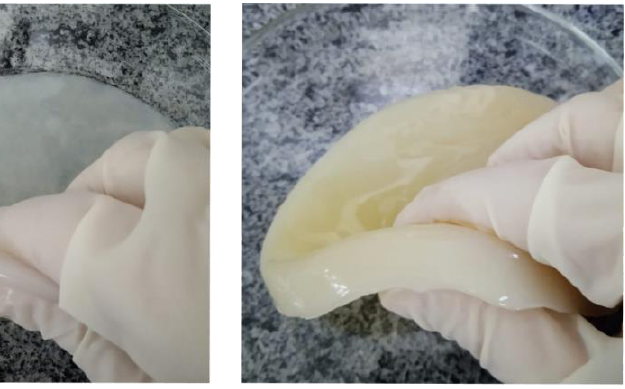
Figure 2. BC production process. Not all bacteria can produce BC. In general, the genera Sarcina , Komagateibacter , Pseu- domonas , Rhizobium and Agrobacterium are good producers. There are also specific culture media for production that must contain sources of carbon, nitrogen, and some mineral salts. The most widely used medium is the one formulated by Hestrin and Schramm [38], which is expensive, as it contains high purity reagents such as glucose, peptone, yeast extract, citric acid, and sodium diphosphate. Some of the residues used come from cereals and grains such as oats, soybeans, corn, wheat, beans, peanuts, coffee, and barley, from fruits and vegetables such as tomatoes, oranges, apples, grapes, bananas, mangoes, coco- nuts and cocoa, and also residues from other vegetables such as cotton, palm and tea herbs [15,38 – 40]. The use of agro-industrial residues to produce BC membranes is a good option for reducing costs, especially if scaled to industrial manufacturing. It also enables the re- use of materials that would otherwise be discarded [41 – 43].